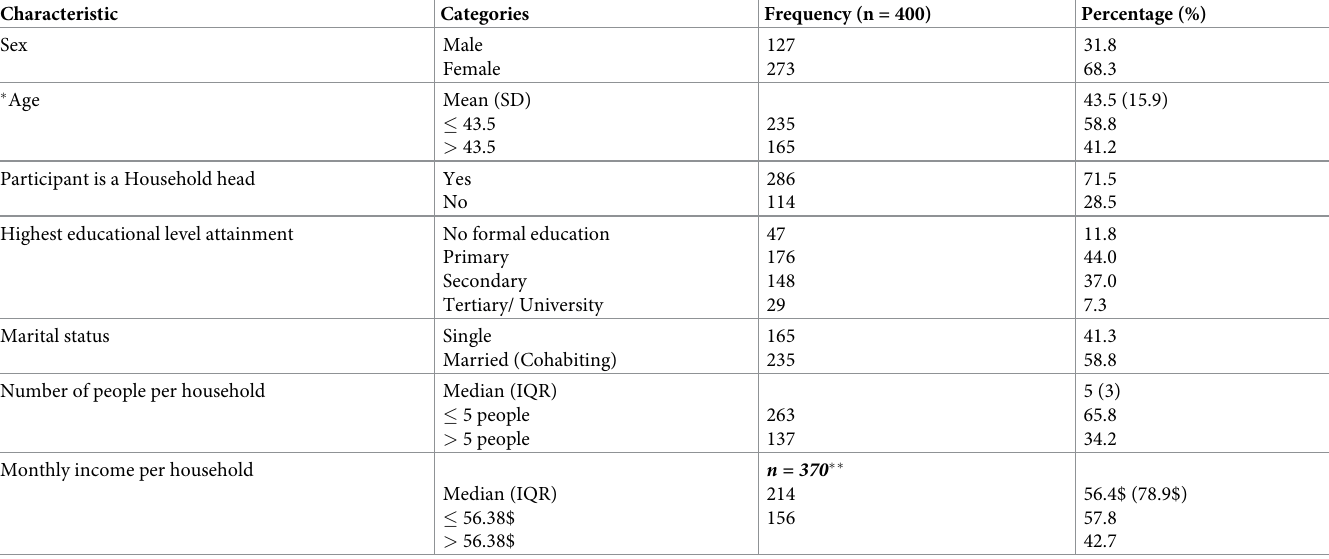
Table 1. Background characteristics of